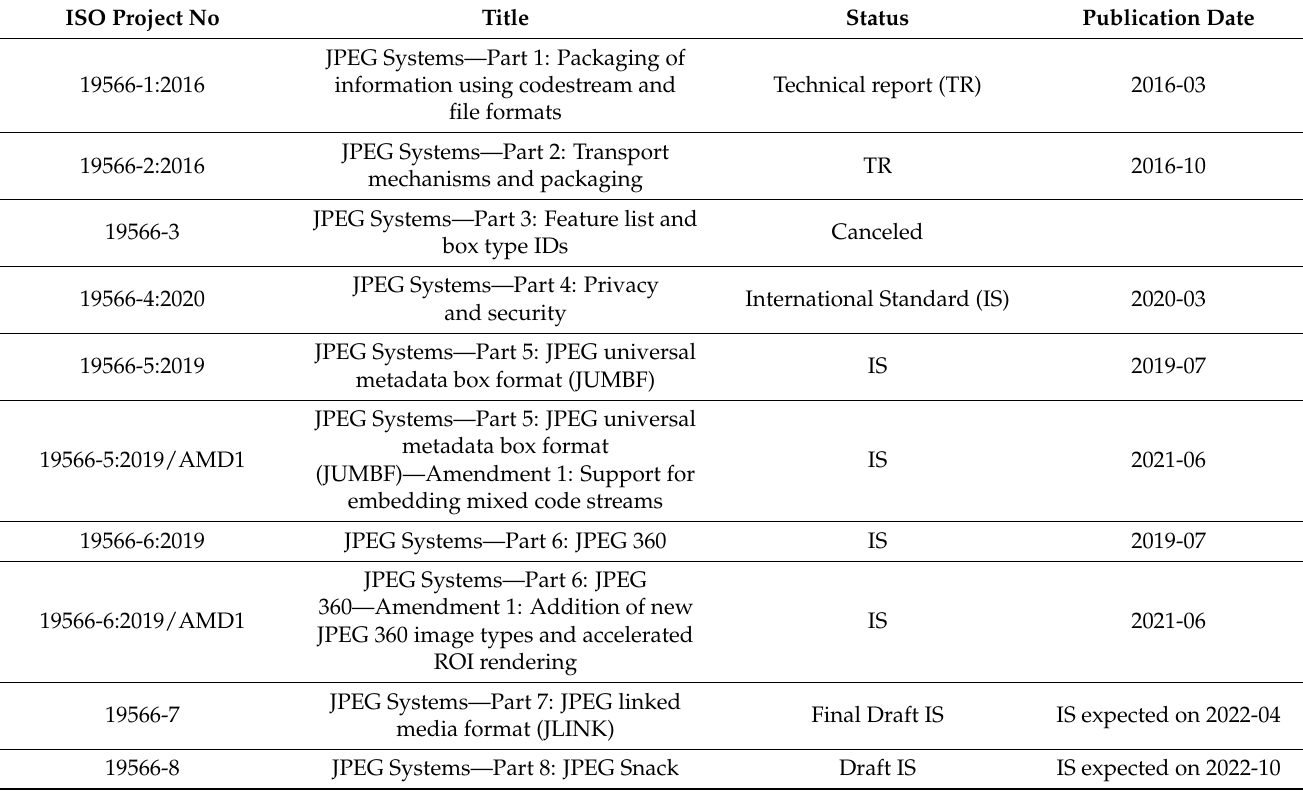
Table 1. Status of JPEG Systems ISO